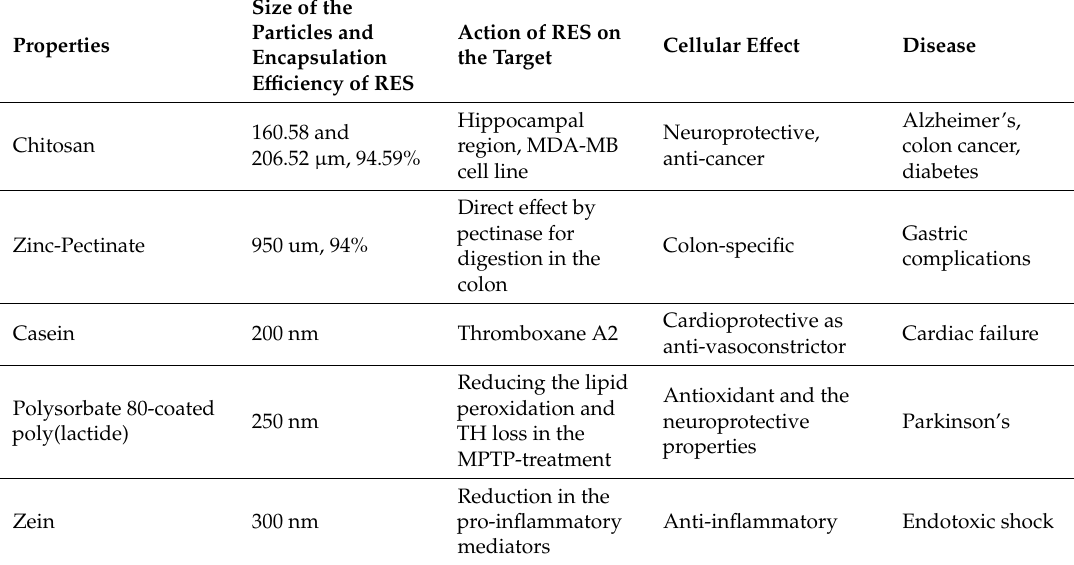
Table 1. A promising therapeutic advancement of various resveratrol